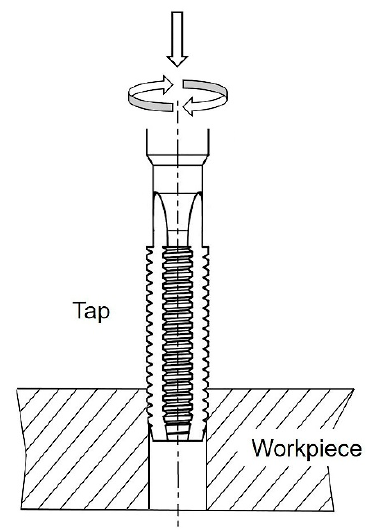
Figure 2. Scheme of the tapping test.